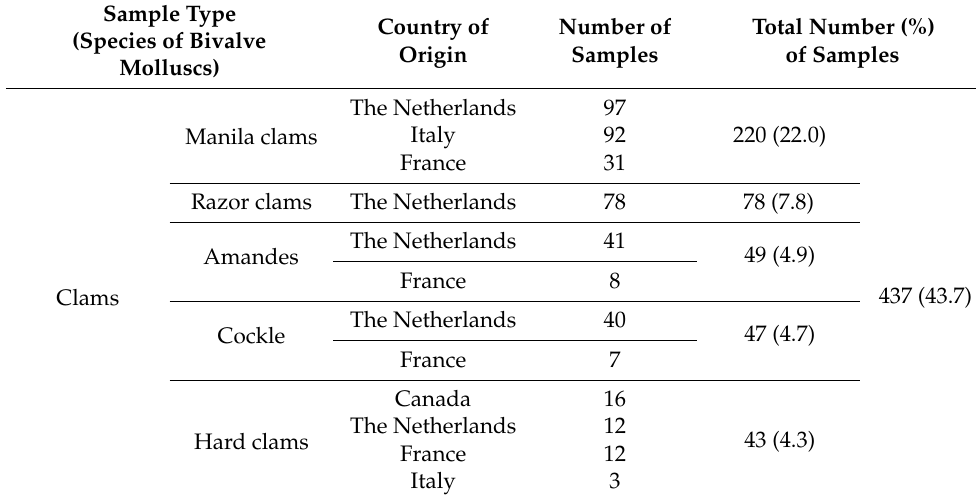
Table 1. Samples used for microbiological